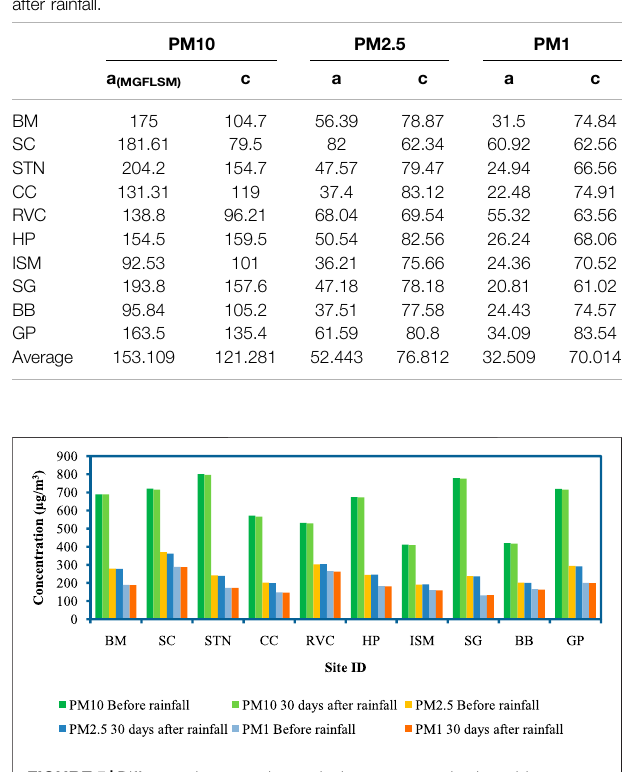
FIGURE 5 | Difference between the particulate concentration in ambient air before rainfall and after 30 days from